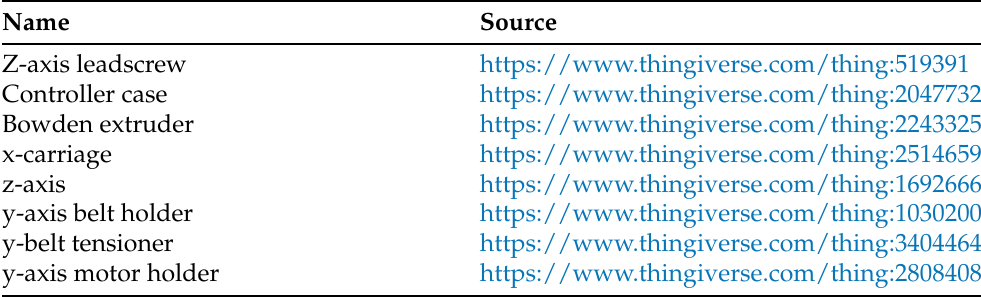
Table A1. Printed components. Accessed on 3 July 2021.